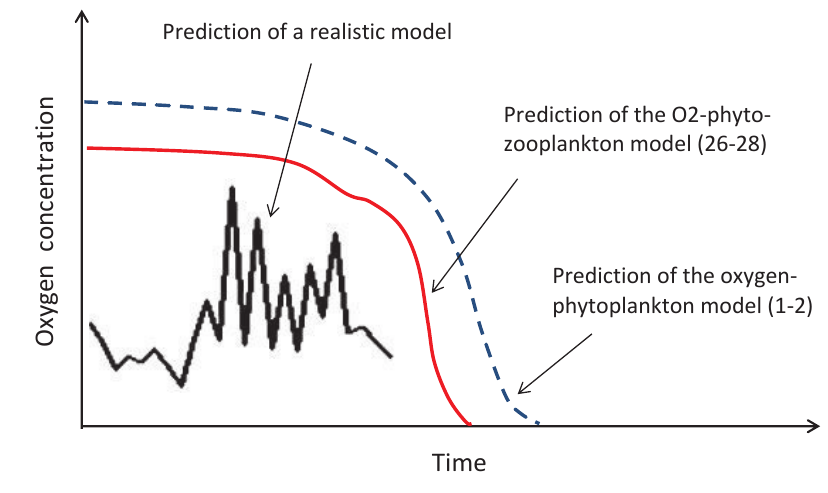
Figure 16. Sketch explaining the relation between the conceptual Equations (1) and (2) (dashed blue curve) and Equations (26)–(28) (solid red curve) and a hypothetical multi-component ‘realistic’ model (black